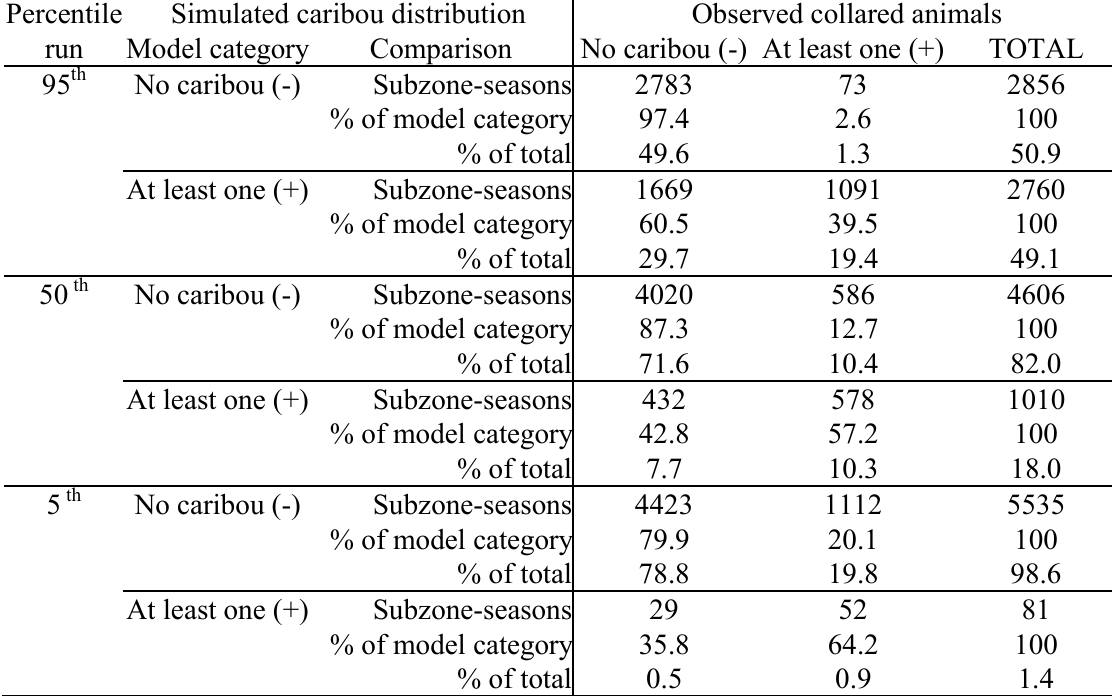
Table A1.2. Cross-tabulation of simulated caribou distribution by observed satellite locations: 5616 subzone-seasons (39 subzones, 8 seasons per year, 18 years), percentiles indicate rank of simulation runs (0=least predicted caribou in the subzone that season and year, 100=most)